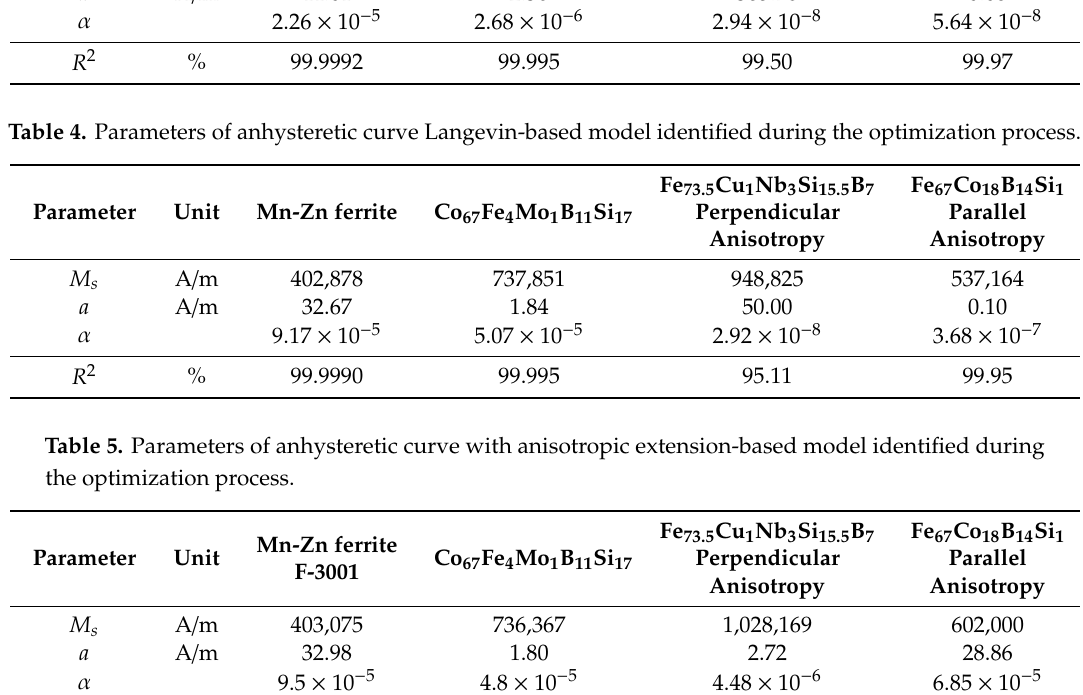
Table 4. Parameters of anhysteretic curve Langevin-based model identified during the optimization process.